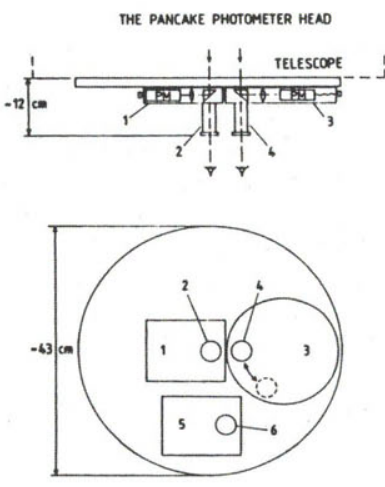
Fig. 1. The Pancake photometer head (simplified): 1 - the first channel housing; 2, 4 and 6 - microscopes; 3 - the second channel housing; 5 - the third channel